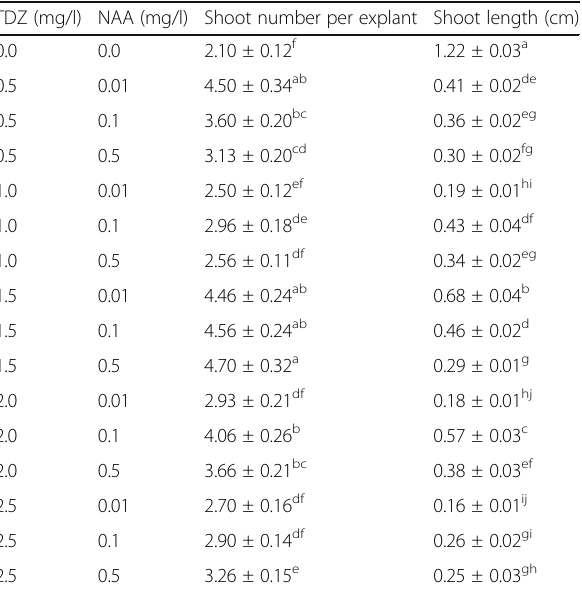
Table 6 Effect of different concentrations of TDZ and NAA on shoot multiplication (shoot number and length) of S.